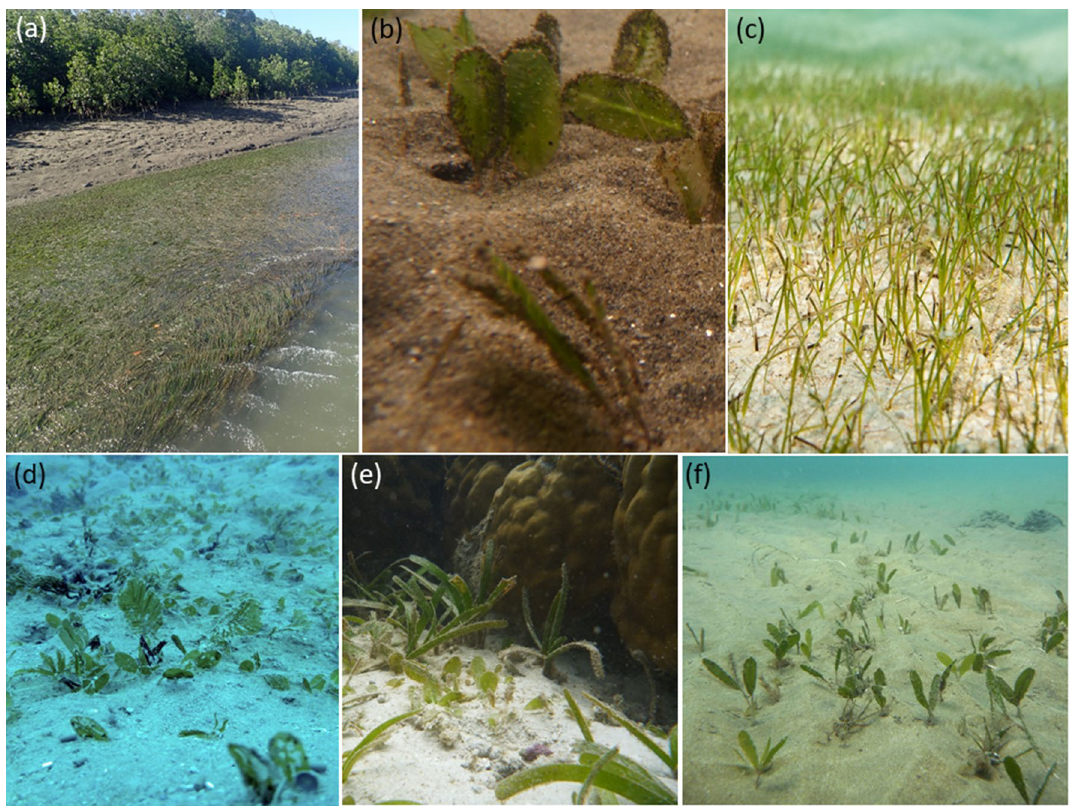
Figure 4. Common seagrass communities in the Great Barrier Reef World Heritage Area and adjacent estuaries: ( a ) estuary intertidal Z. capricorni , ( b ) estuary subtidal H. ovalis dominated, ( c ) coastal intertidal H. uninervis dominated, ( d ) coastal subtidal H. ovalis and H. spinulosa , ( e ) reef intertidal T. hemprichii and H. ovalis , and ( f ) reef subtidal H. decipiens . Photo credit: TropWATER, James Cook